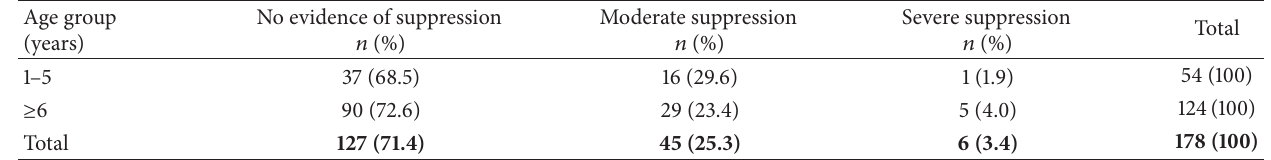
Table 3: Immunologic classification of the study participants based on the CDC immunologic classification.